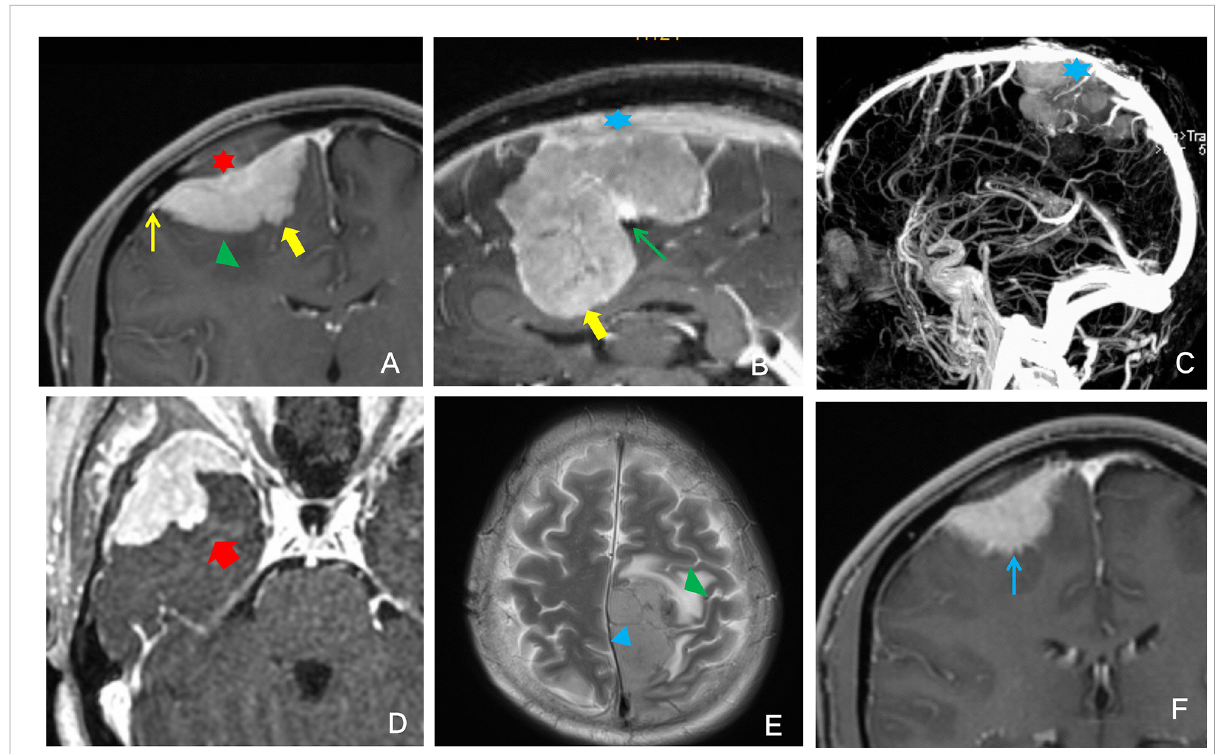
FIGURE 1 Illustrative example of the description of the analyzed imaging features. (A) Red star: bone invasion; green triangle: peritumoral edema; thin yellow arrow: dural tail sign; thick yellow arrow: fi nger-like protrusion. (B) Blue star: venous sinus invasion; thin green arrow: lobulated sign; thick yellow arrow: fi nger-like protrusion. (C) Blue star: venous sinus invasion. (D) The thick red arrow points to the enhanced signal as the mushroom sign. (E) Green triangle: peritumoral edema; blue triangle: vascular fl ow void. (F) Thin blue arrow: unclear tumor-brain